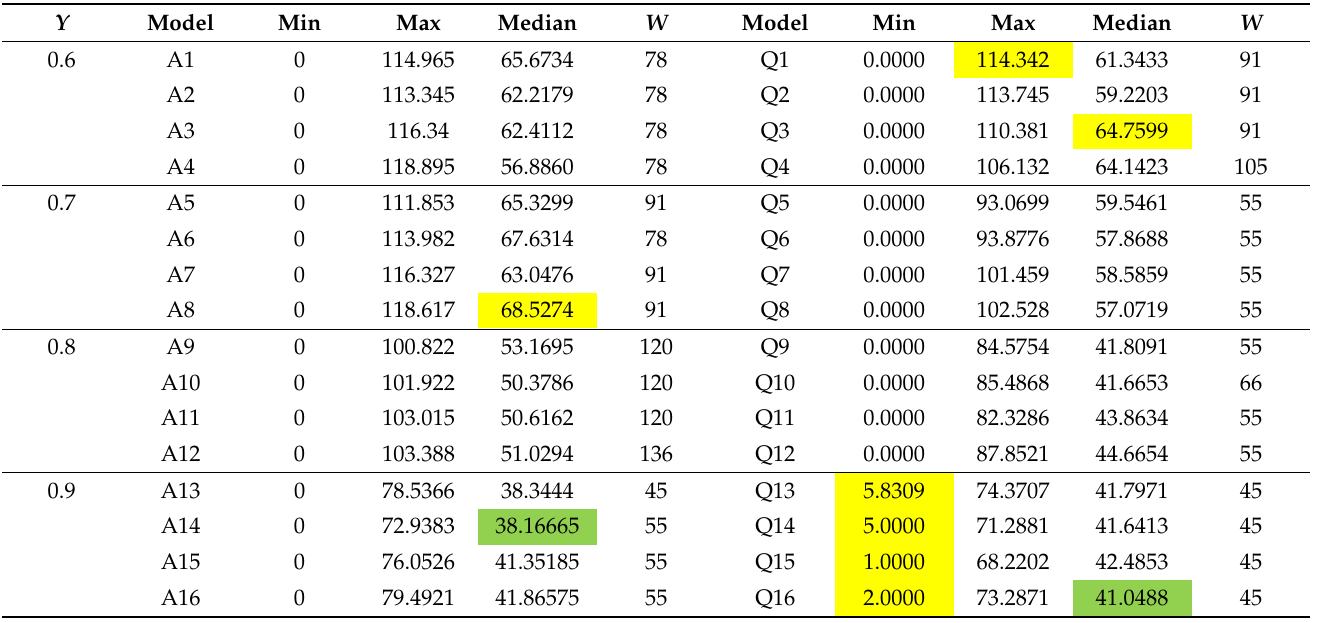
Table 12. Maximum and minimum RMSEtrain results for models in both type of logic δ 1 2 SAT ρ , δ 2 2 SAT ρ details by Wilcoxon test for median.